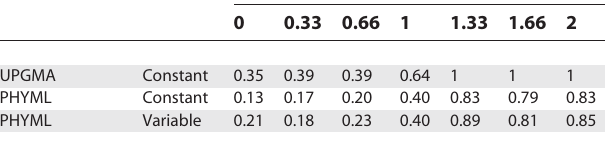
Table 7. The Power of the Mean I 9 Test to Detect Tree Imbalance Using Reconstructed Gene Genealogies Reconstruction Method